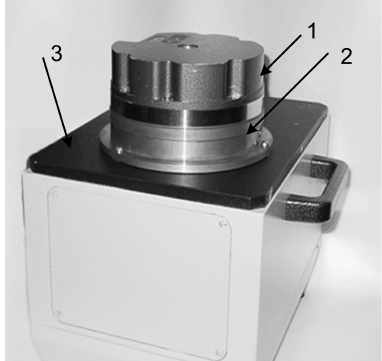
Figure5. InstallationoftheLDGforthecalibrationofopticalencoders;1–RON-905;2–adjustment Figure 5. Installation of the LDG for the calibration of optical encoders; 1—RON-905; ring;3–LDG 2—adjustment ring;